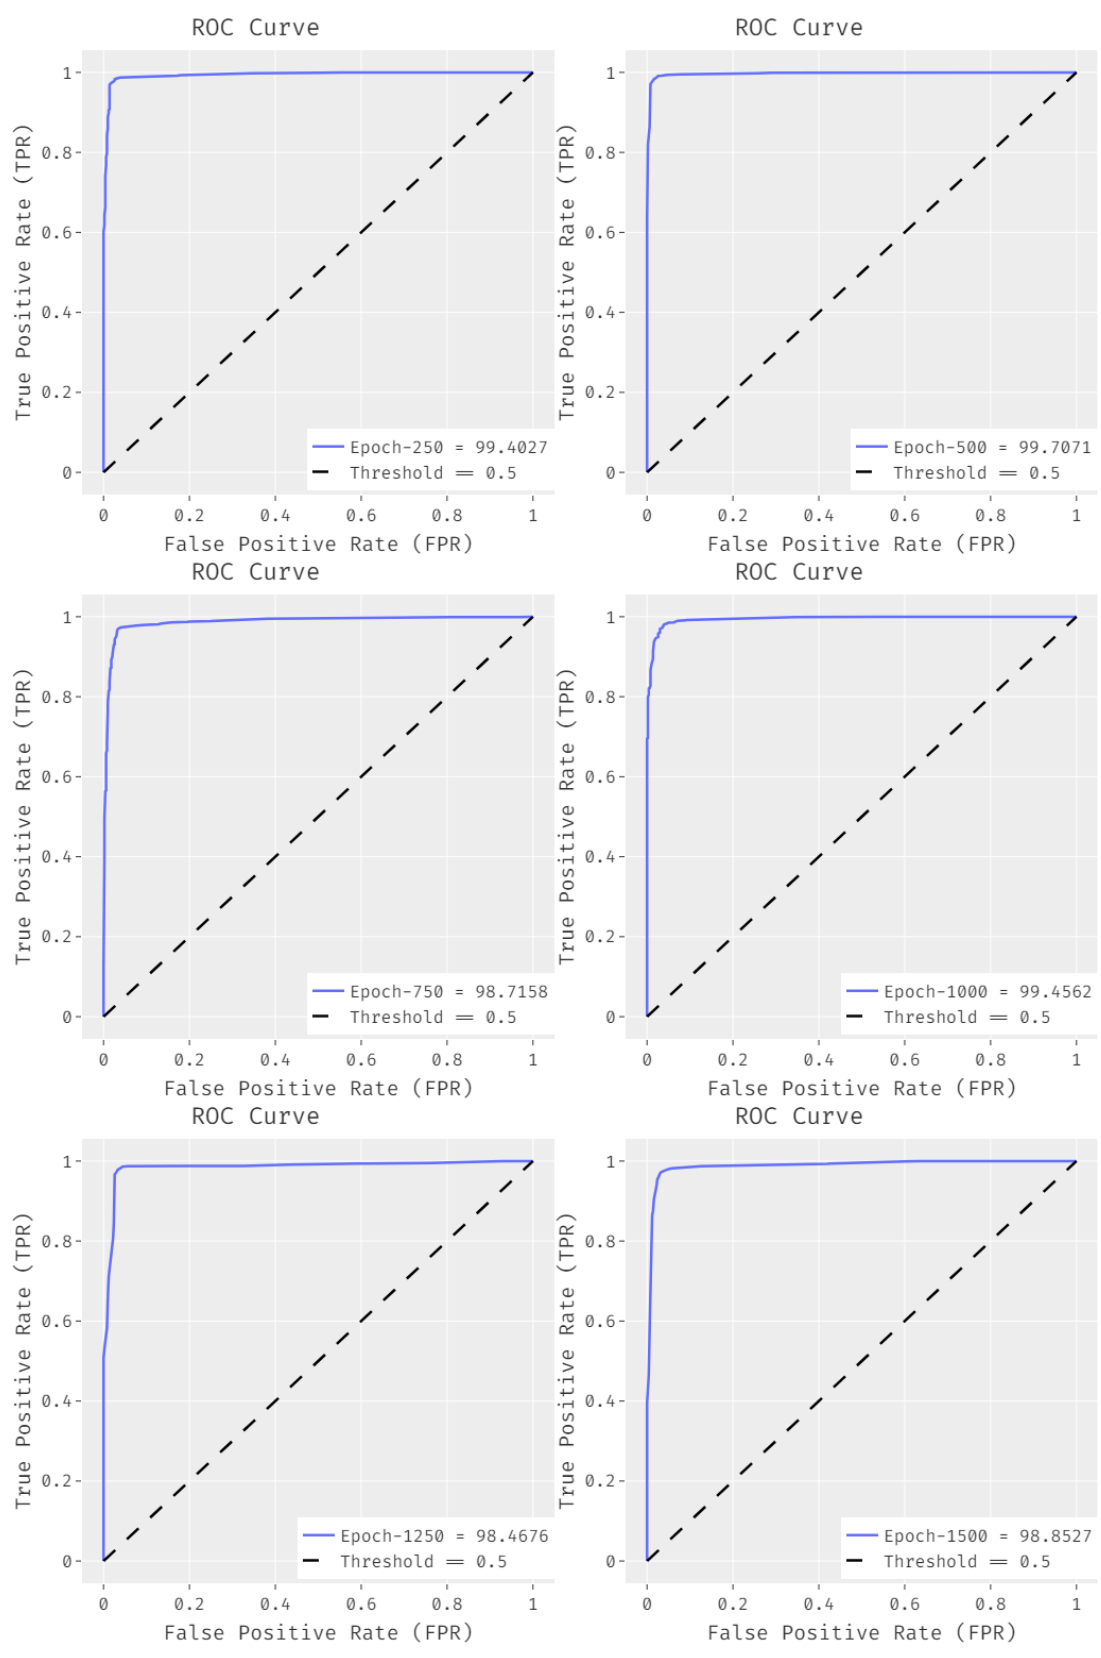
Figure 8. ROC analysis results for the EDLCDS ‐ BCDC technique under distinct epochs.